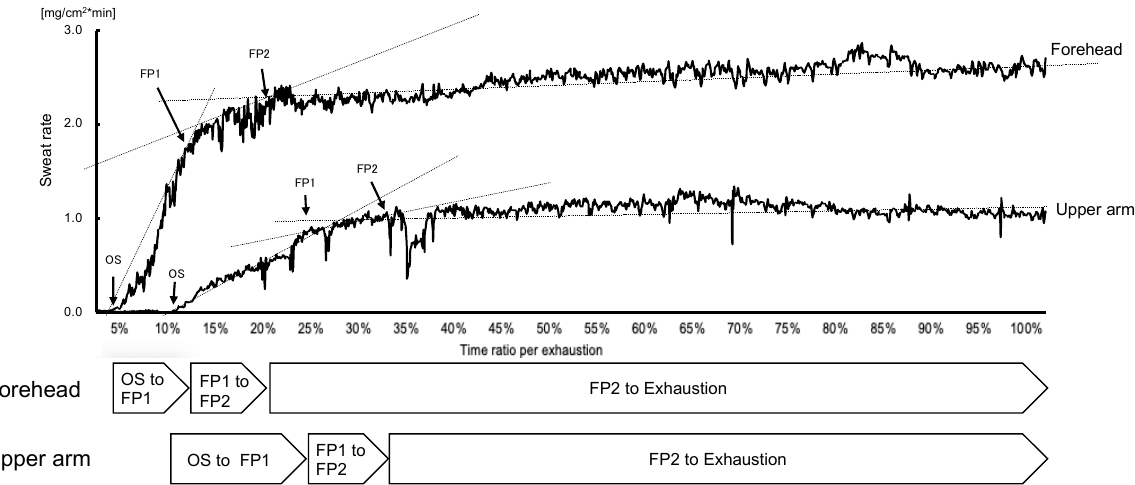
Figure 1. Representative data of the local sweat rate during constant-load exercise until exhaustion. This figure shows a representative graph of the local sweat rate over time from the start of the constant-load pedaling exercise to the end of the exercise (until exhaustion). After the onset of sweating, the sweat rate rapidly increases (OS to FP1), followed by a lower slope of the increment (FP1 to FP2), and finally, a state of slight decrease (FP2 to exhaustion), which is characteristic of the local sweat rate at the forehead. Abbreviations: FP, flexion point: OS, onset of sweating. For both LSRs, the incremental LSR slope in each of the periods, from OS to FP1 (LSRslope [OS-FP1]), FP1 to FP2 (LSRslope [FP1-FP2]), and FP2 to exhaustion (LSRslope [FP2-Exh]), was calculated by dividing the difference between the LSR at the beginning and end of each period by the time of each period. Those slopes were decreased significantly over time (hLSR, p < 0.01, partial η 2 = 0.79; aLSR, p < 0.01, η 2 = 1.00; Figure 2). One partici- pant showed unique kinetics for hLSR and aLSR, which had more than two flexion points and decremental LSR following the peak (Figure S1). Notably, this participant had the highest body fat ratio (24.5%) and the lowest body water ratio (49.9%) of the 18 participants (Table S1). The data of this participant was excluded from further analysis.